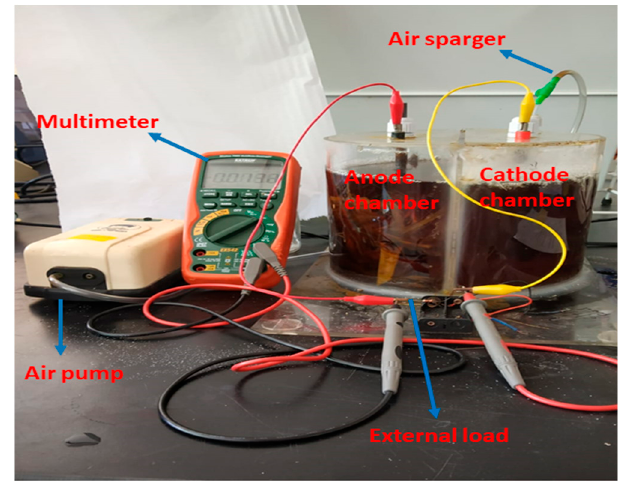
Figure 1. An active benthic microbial fuel cell (BMFC) model. 96